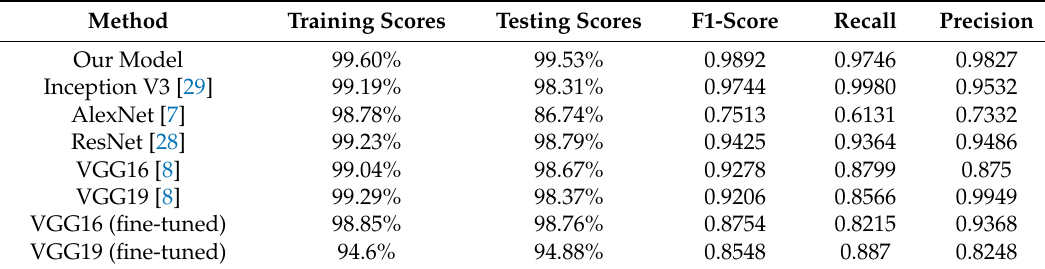
Figure 8. Comparing the performance of the models ( a , b ). The x - and y -axes show the number of epochs (250) and the training accuracies of the models, respectively. Table 6. Training and testing scores of our network against those of well-known